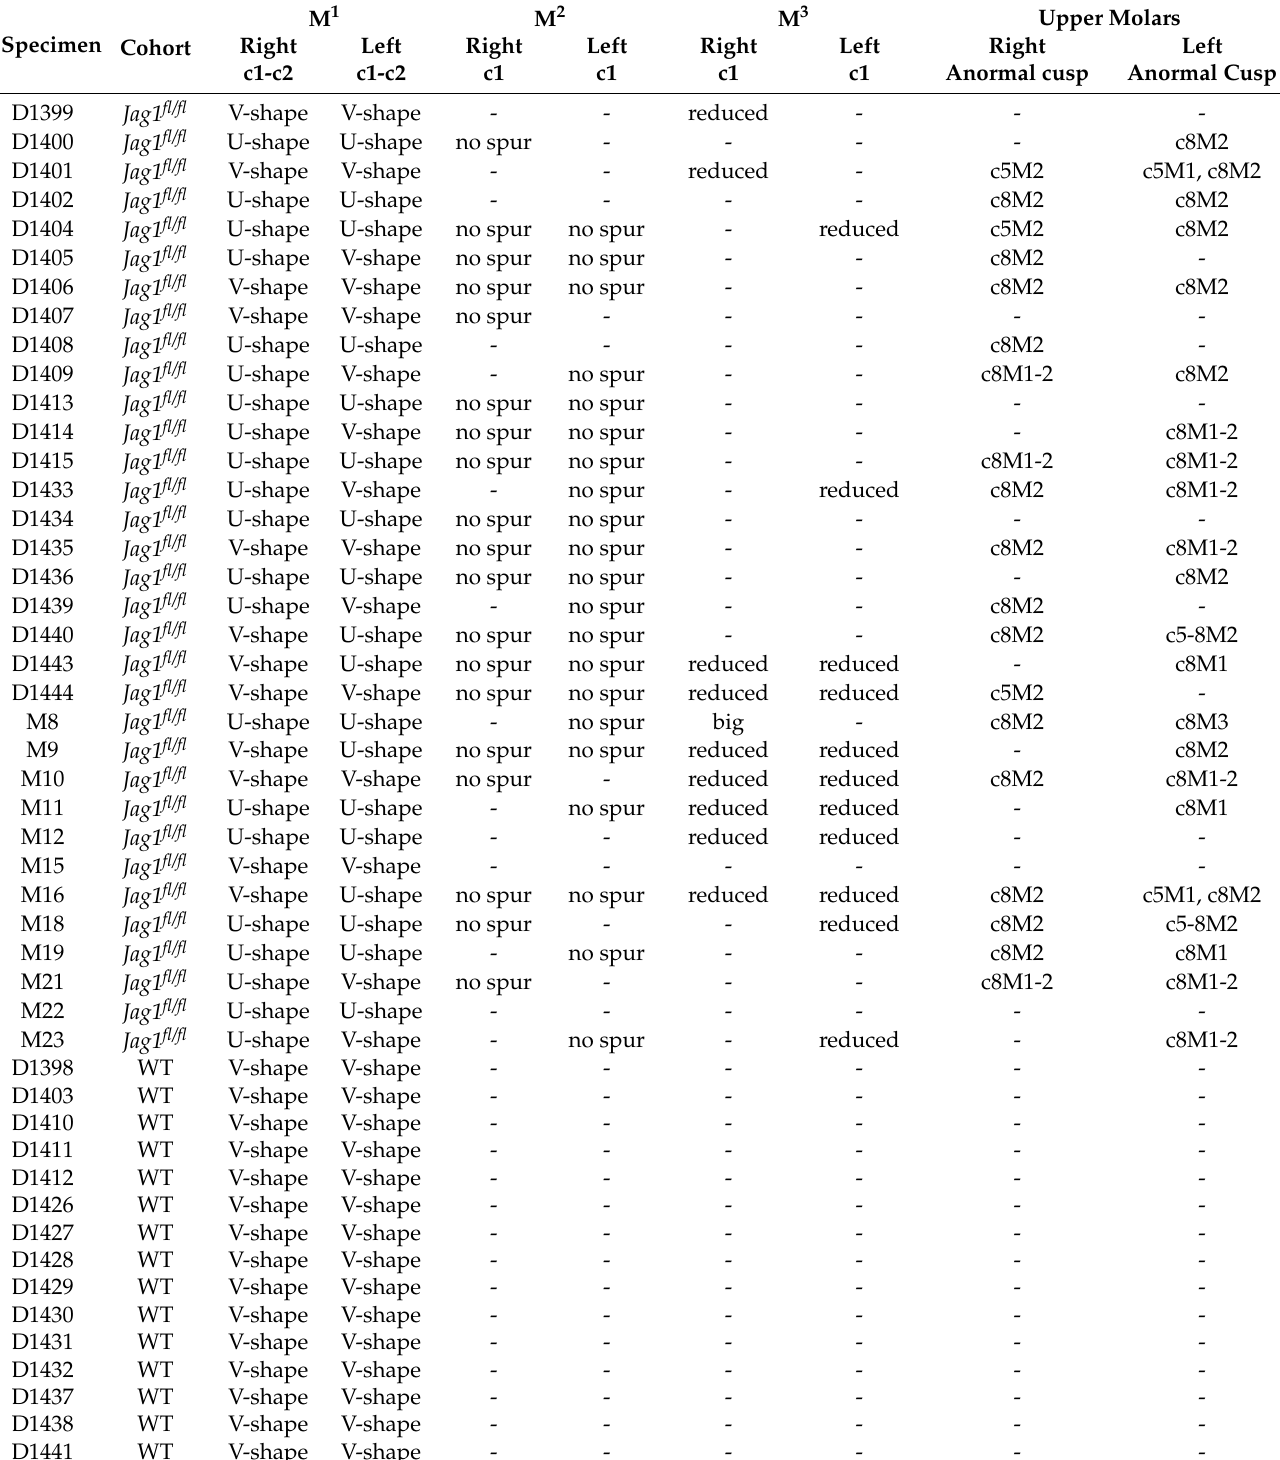
Table 2. Morphological variations in the upper molars of K14Cre;Jagged1 fl/fl mice. On the first upper molars (M 1 ) of wild-type (WT) mice, the interconnection of the first (c1) and second (c2) cusps has a V-shape profile, while this profile is often U-shaped (60%) in K14Cre;Jagged1 fl/fl M 1